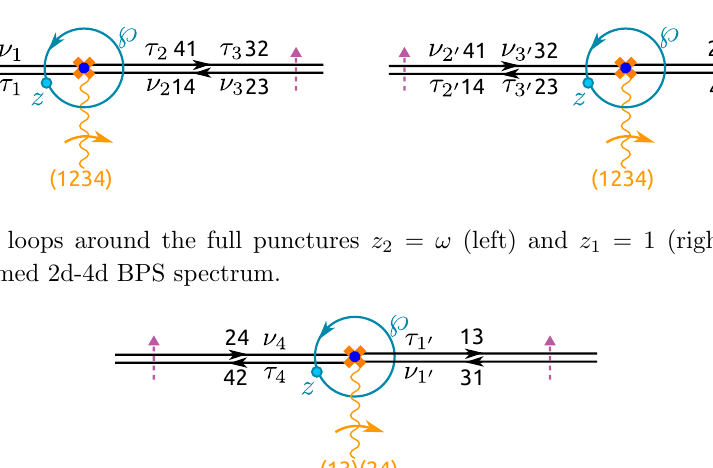
Figure 4 . Resolution of the spectral network of (cid:12)gure 3. Each double wall from (cid:12)gure 3 has been replaced by two in(cid:12)nitesimally separated walls. The walls carrying labels 14 and 23 are on top of one another even after the resolution, and likewise for those with labels 41 and 32.